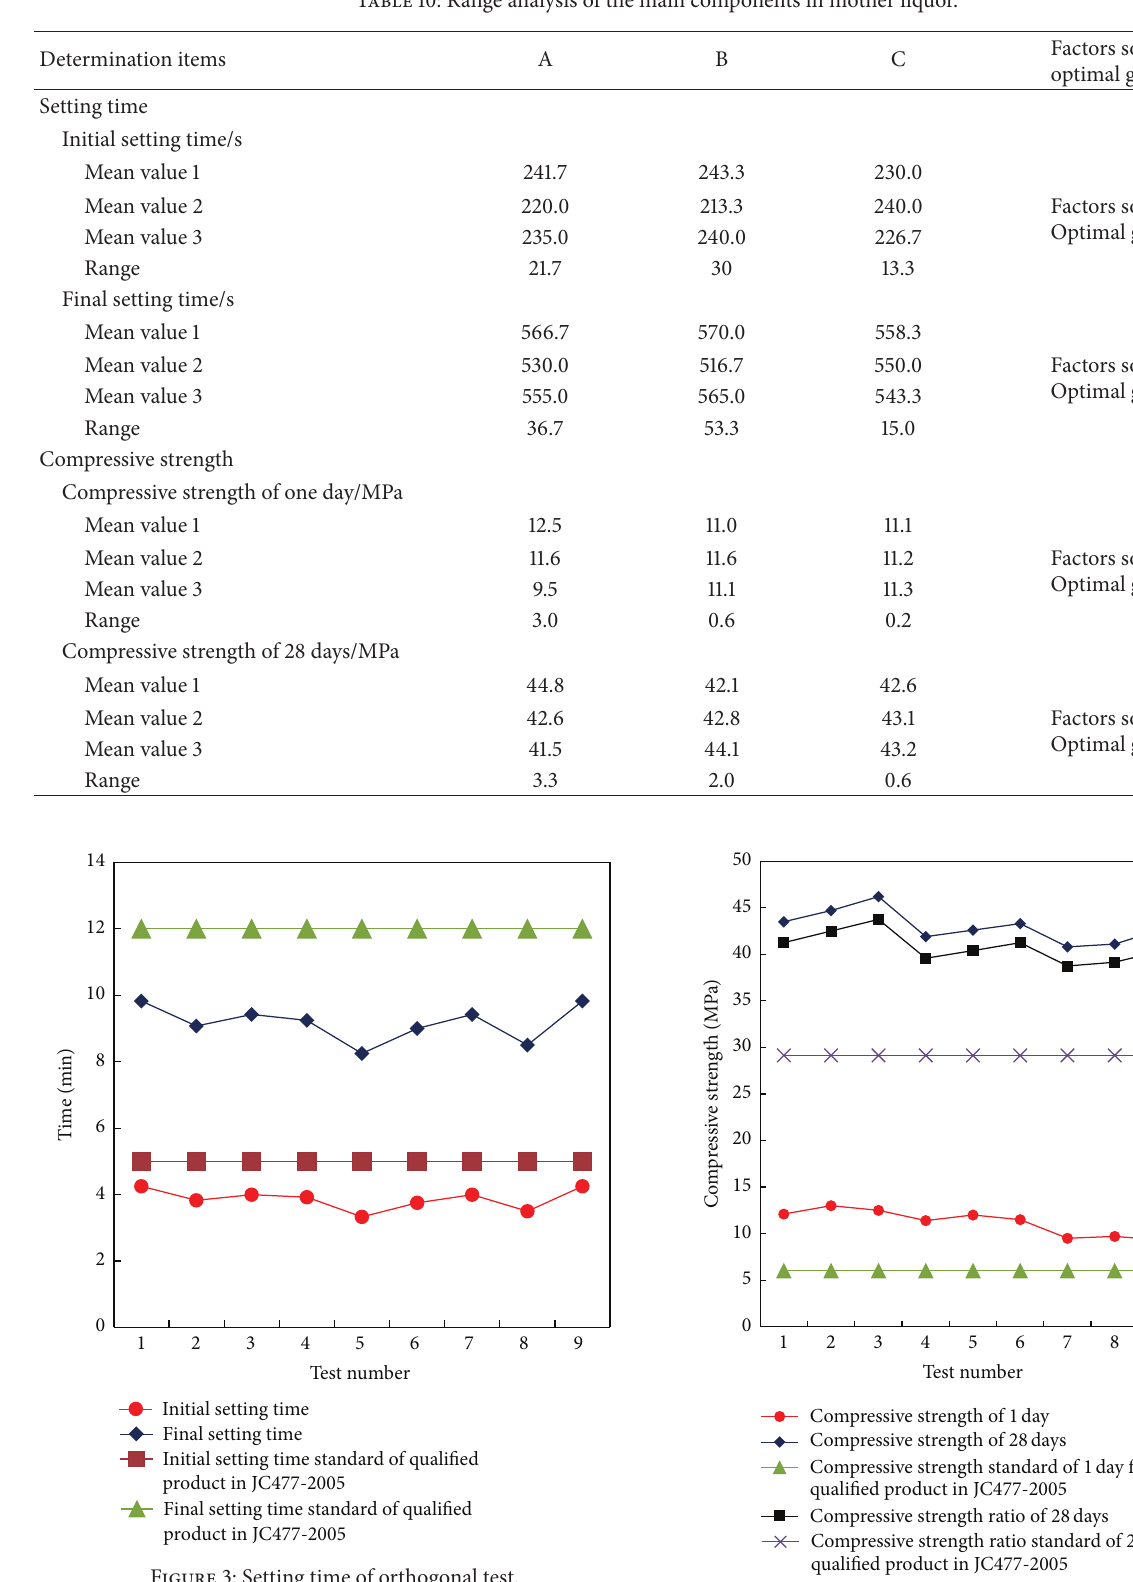
Table 10: Range analysis of the main components in mother liquor.